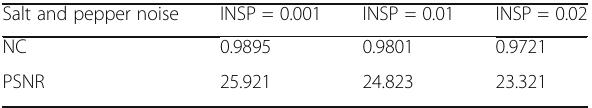
Table 4 Adding the salt and pepper noise attack with Example 2 Salt and pepper noise INSP = 0.001 INSP =